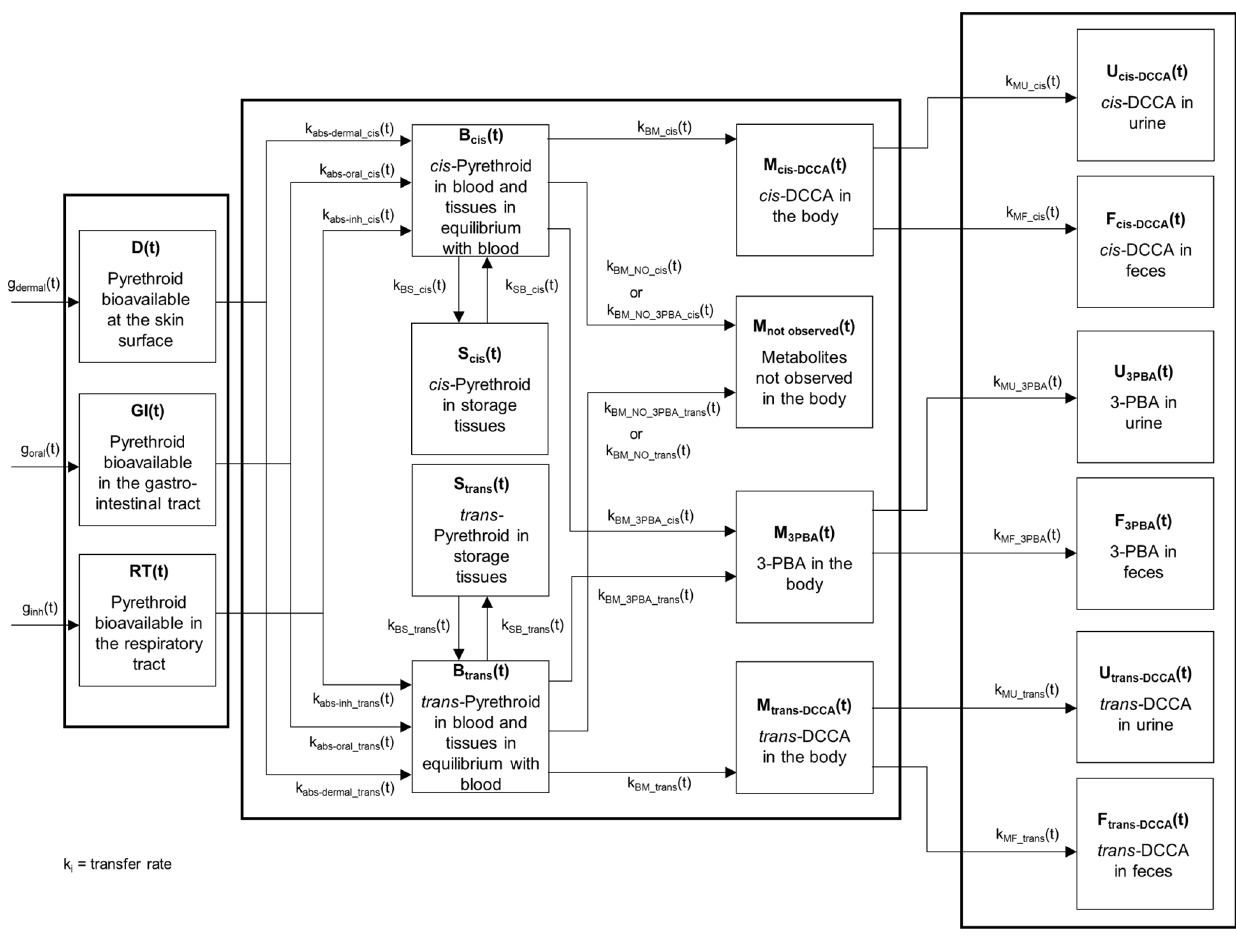
Figure 1. Model conceptual representation. Model conceptual representation of the kinetics of cis - and trans -permethrin and cypermethrin and their trans -DCCA, cis -DCCA and 3-PBA metabolites. Symbols are described in Table 1.